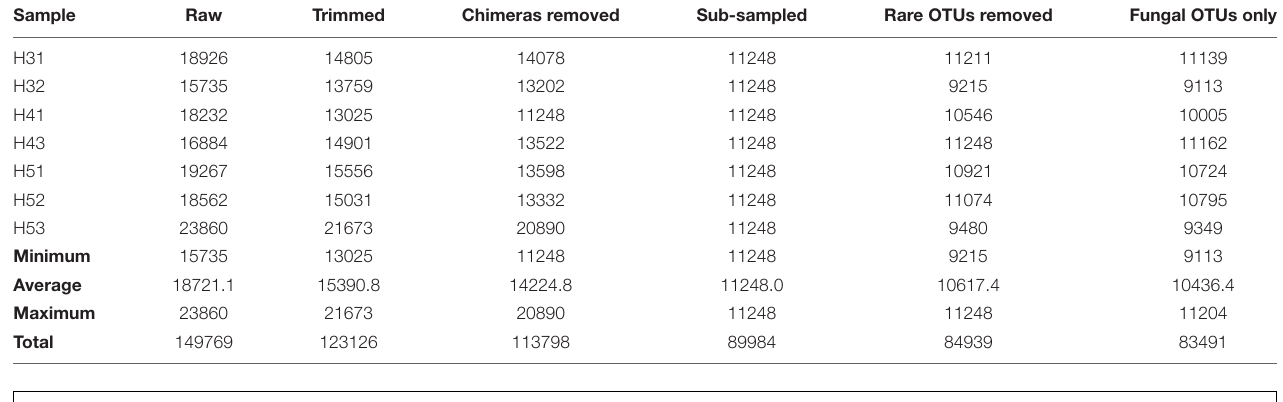
TABLE 2 | Total number of reads at the different stages of the bioinformatic workflow.